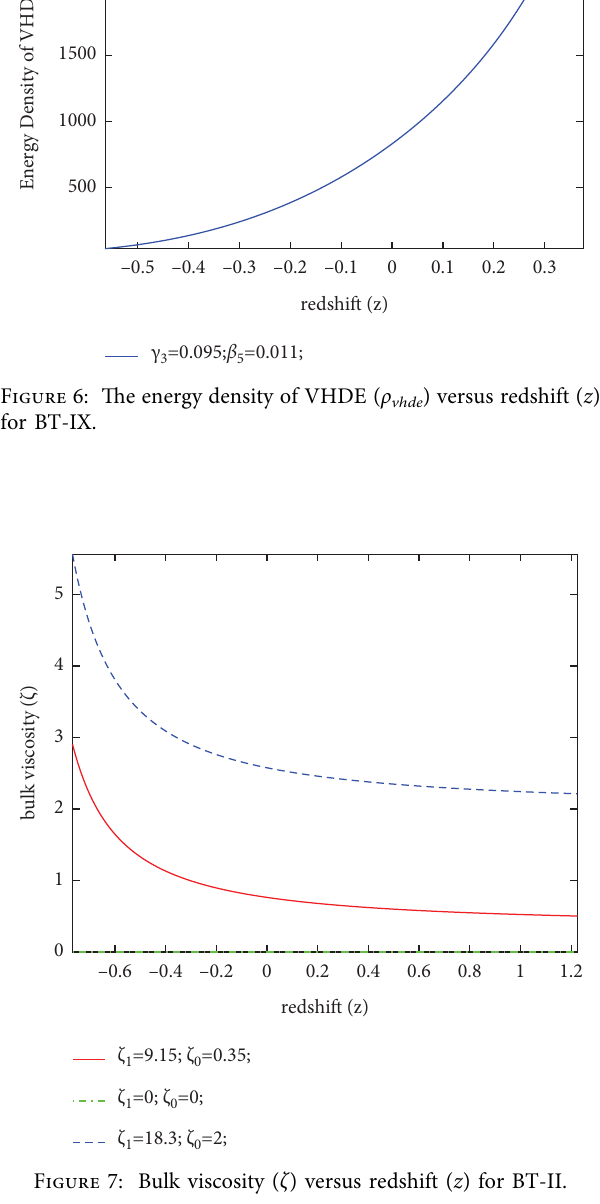
Figure 9: Bulk viscosity ( ζ ) versus redshift ( z ) for